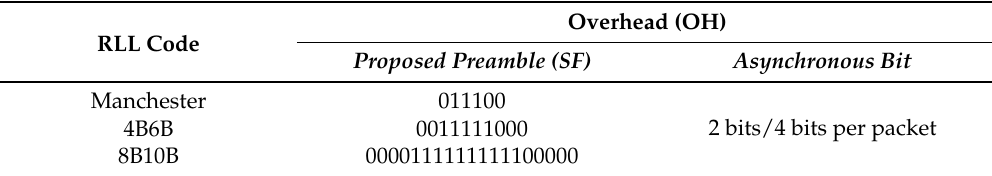
Table 6. Coding schemes and